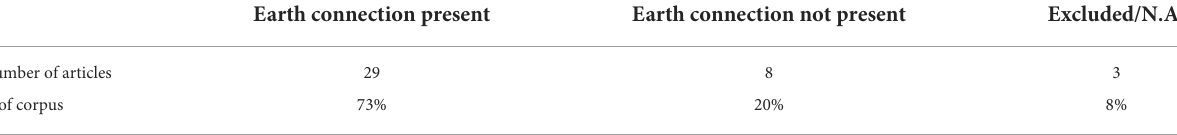
TABLE 3 Number of articles in the deep read analysis containing an earth connection